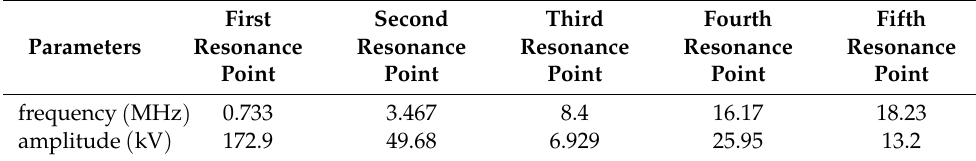
Figure 5. Spectrum of VFTO injected into the front end of the transformer. Table 2. Main parameters of VFTO spectrum.